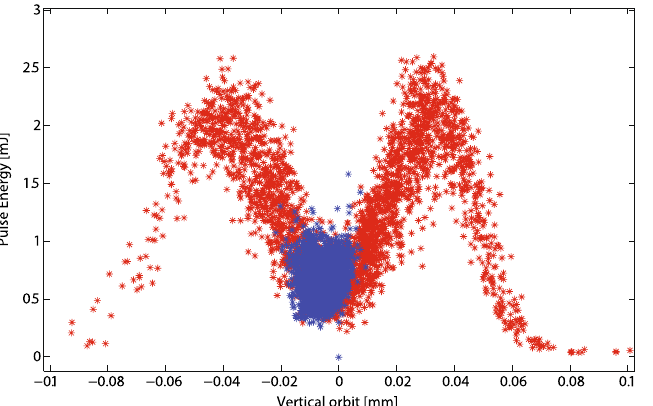
Figure 9. 9.5 keV x-ray pulse energies vs largest vertical electrons measured trajectory in the undulator, for a configuration involving two different x-ray pointing directions (LCLS-I). Two different pointings are achieved with the electron bunches travelling on different vertical orbits. For measured orbits of ∼ ± 40 µ m a single bunch reaches full lasing. For measured orbits close to the undulator axis, both bunches are lasing with a reduction of performance. The red dataset was recorded with a large dispersion of transverse kicks imparted by TCAV3 and shows the full correlation. The blue dataset represents the actual working point with small orbit